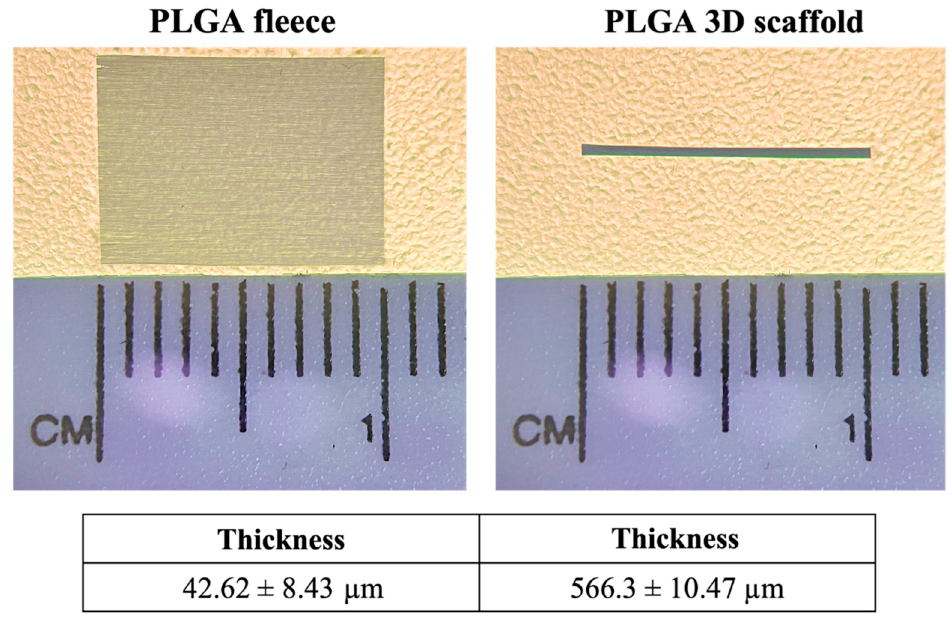
Figure 1. Stereomicroscope observation of PLGA fleeces and 3D scaffolds with their quantified thickness.